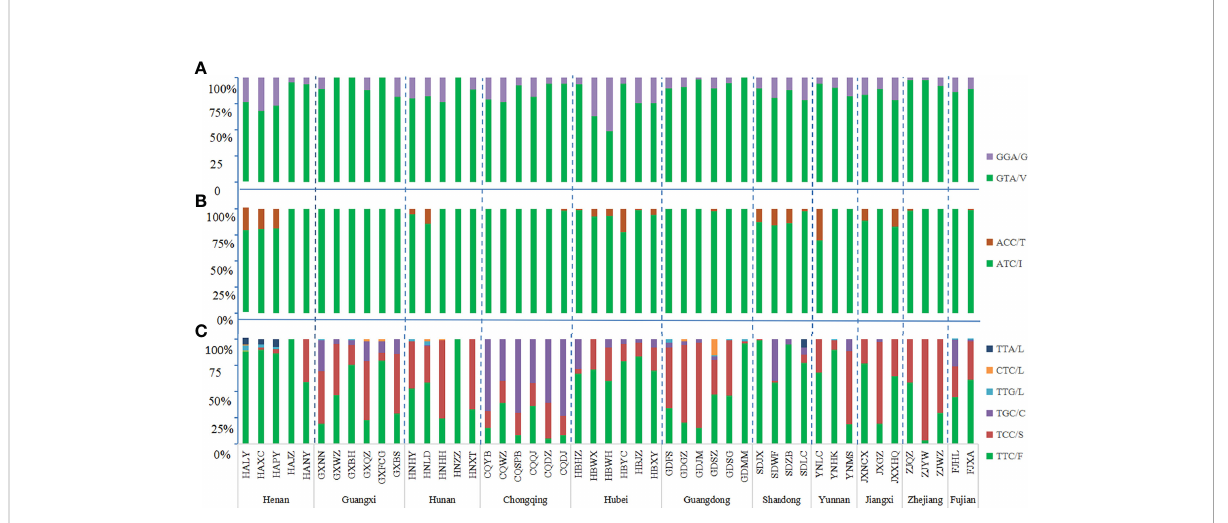
FIGURE 2 Histogram of allele frequency at codons 1016 (A) , 1532 (B) and 1534 (C) of the VGSC in Ae. albopictus populations. For detailed information, see Table S1. The dotted line separates the sites by each province. The horizontal axis indicates the populations (see Table 1 and Figure 1 for detail), while the vertical axis denotes the allele frequency.